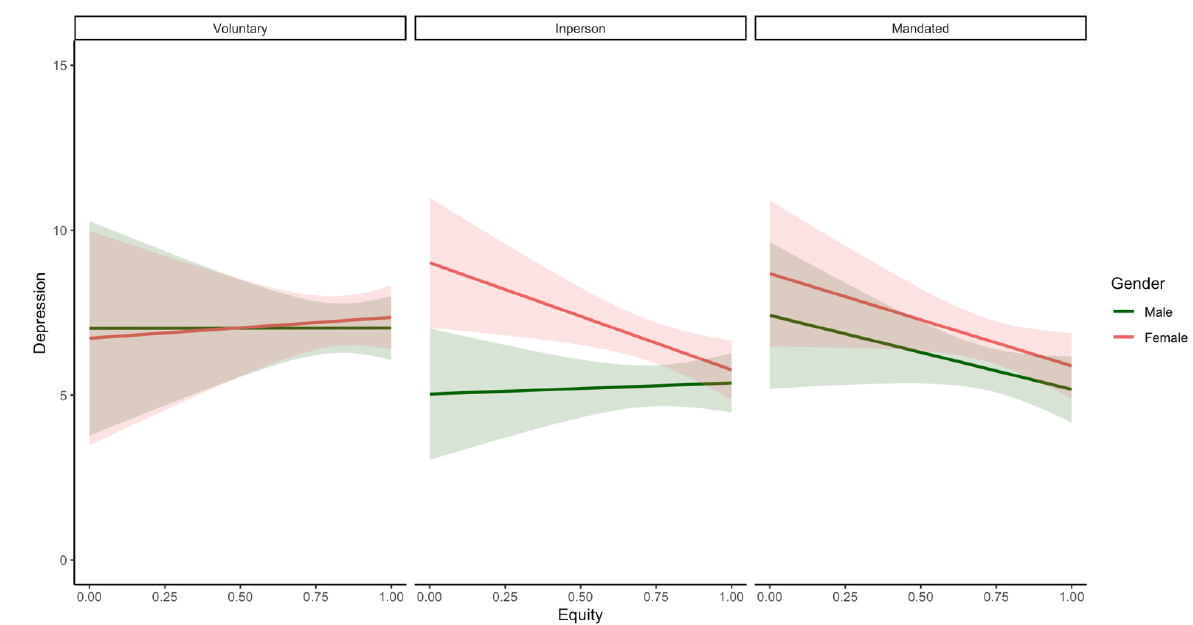
Figure 6. Simple slopes analyses demonstrating the three-way interaction between equity, gender, and schooling status on parents’ depression in mixed-gender couples.